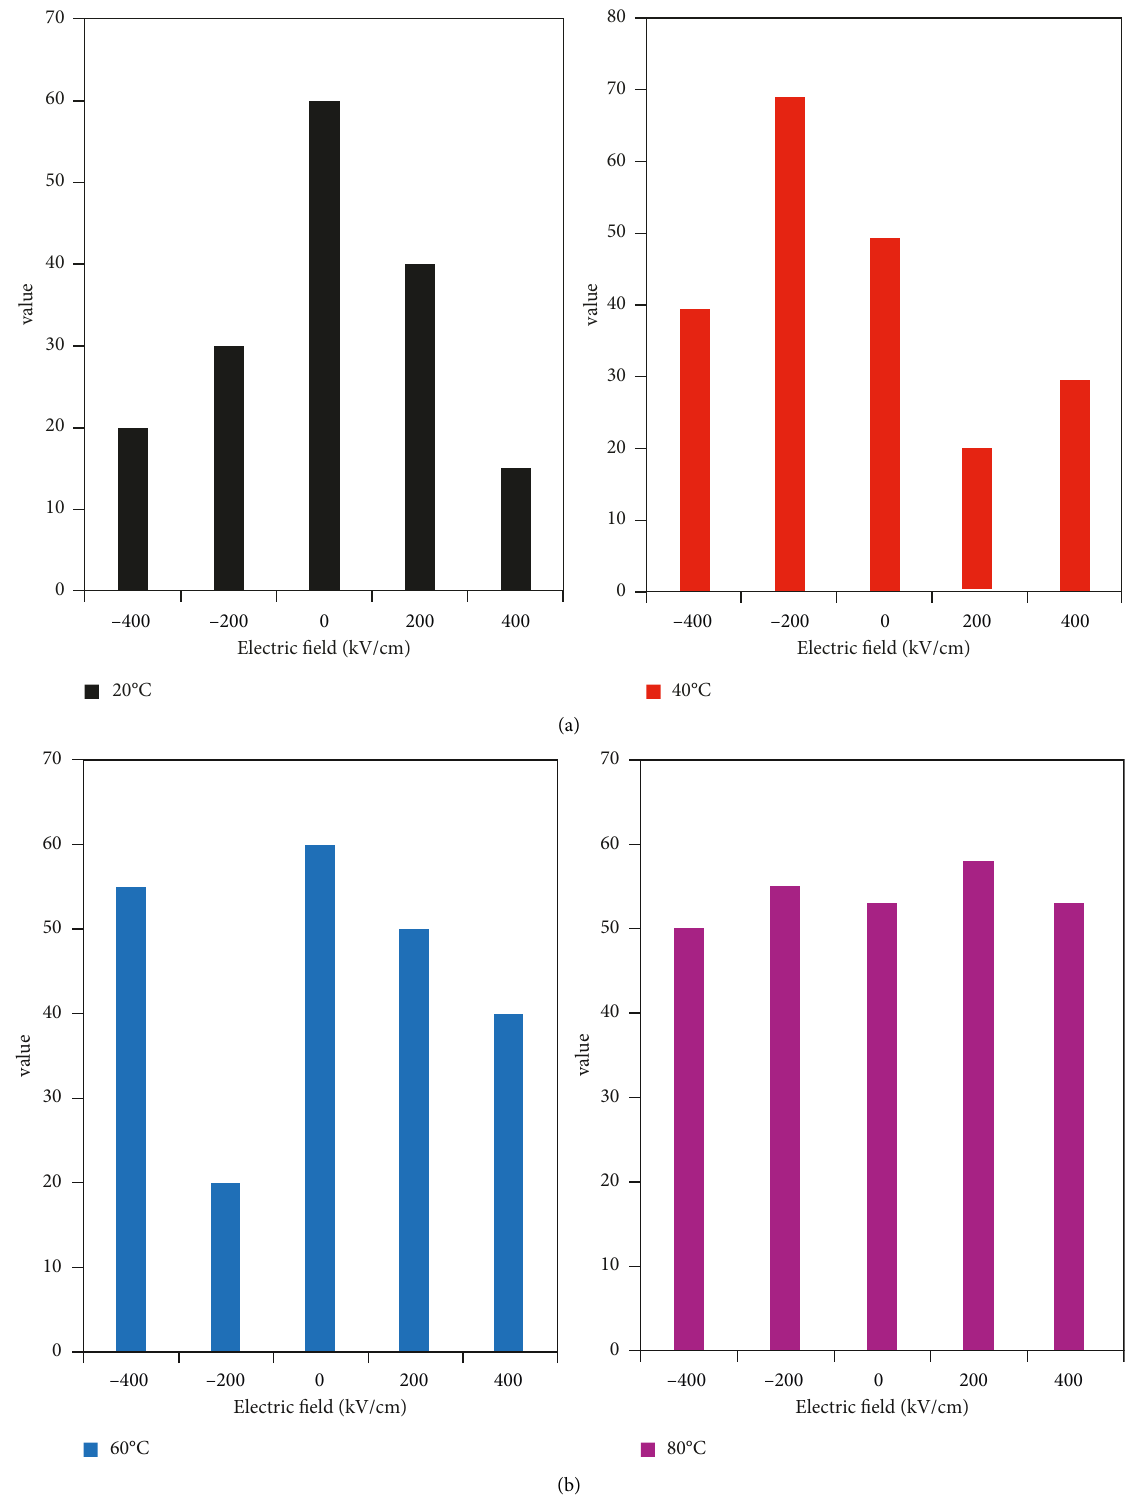
Figure 5: Electric hysteresis loops of Ba 2 TiSi 2 O 8 flexible ferroelectric film at different